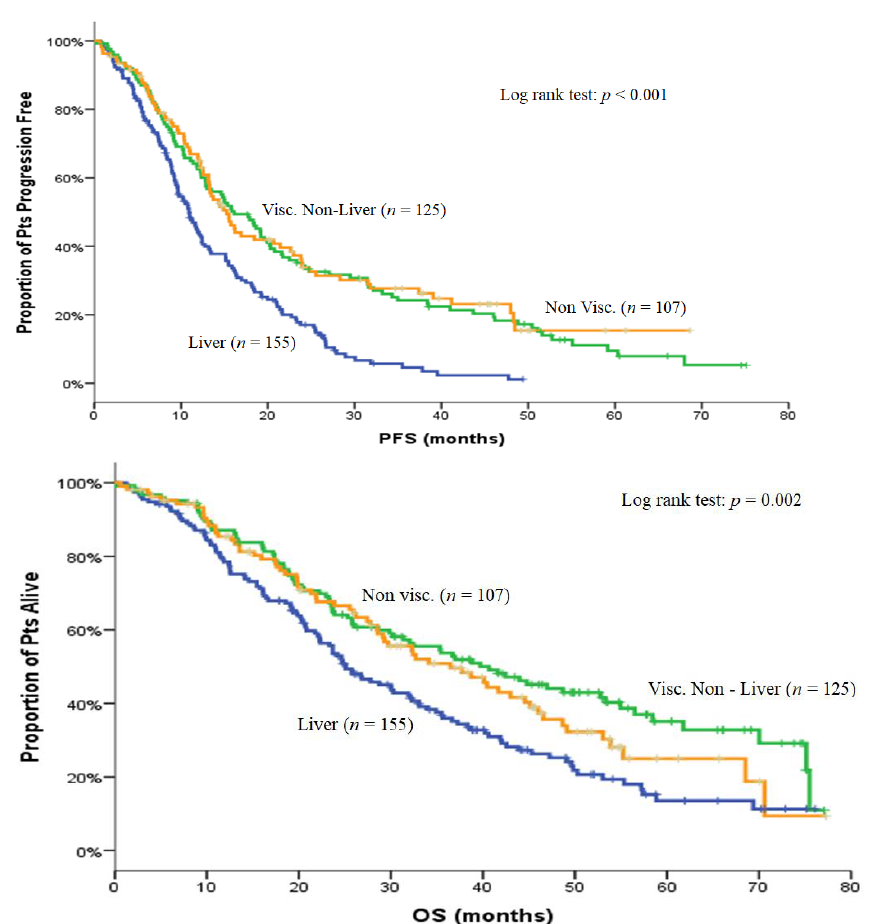
Figure 3. Kaplan–Meier curve for PFS and OS in patients according to visceral-liver, visceral non-liver, and non-visceral metastases.